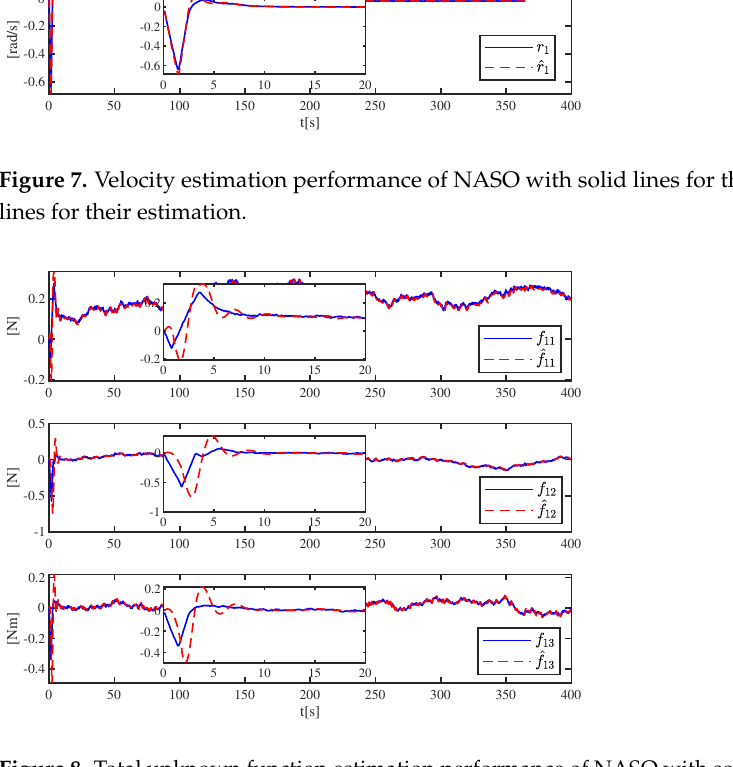
Figure 8. Total unknown function estimation performance of NASO with solid lines for the real states and dashed lines for their